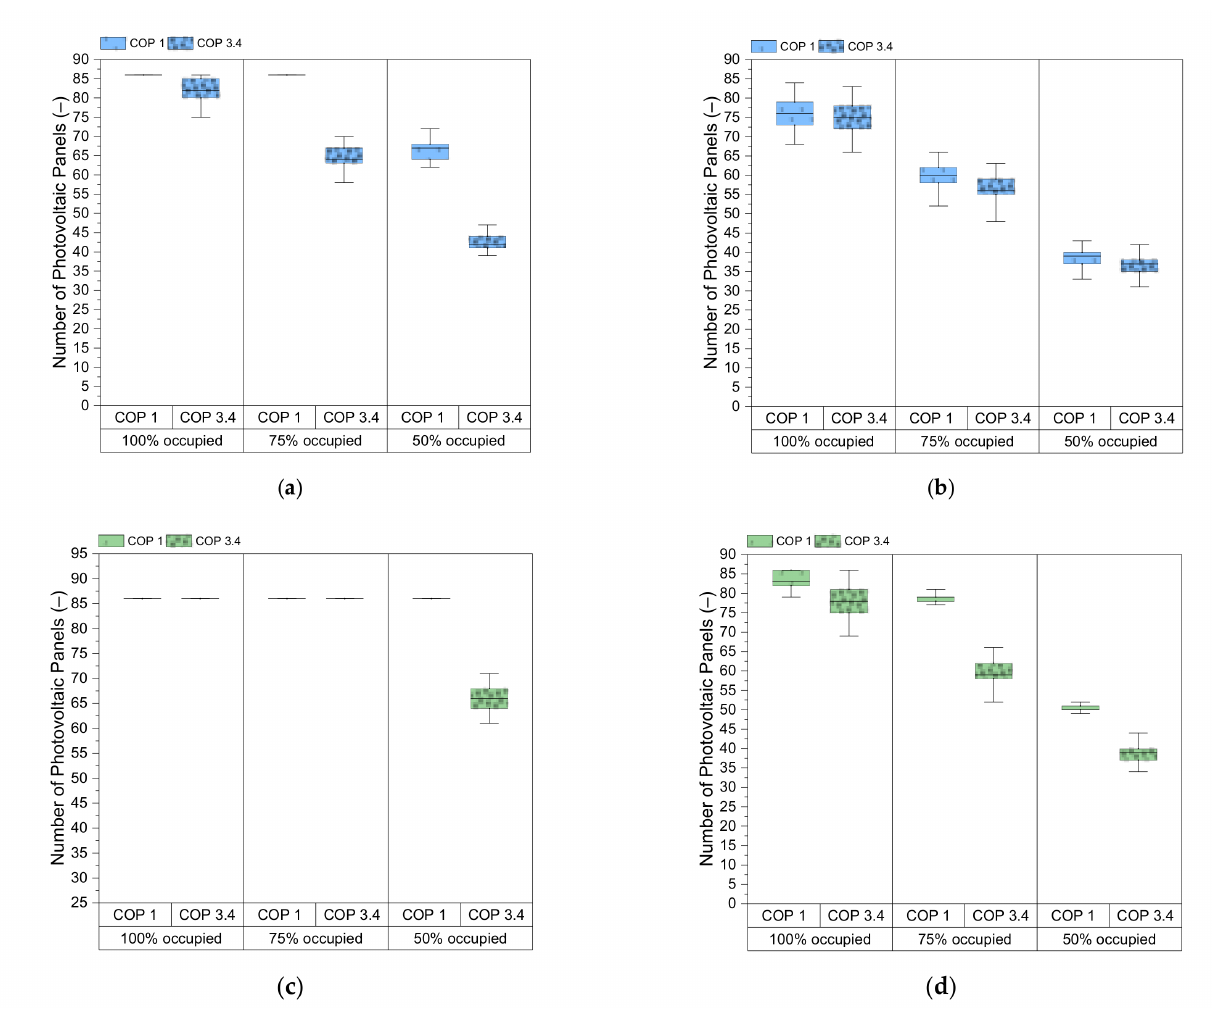
Figure 13. Optimum number of photovoltaic panels: ( a ) Aveiro region with original envelope; ( b ) Aveiro region with improved envelope; ( c ) Bragança region with original envelope; ( d ) Bragança region with improved